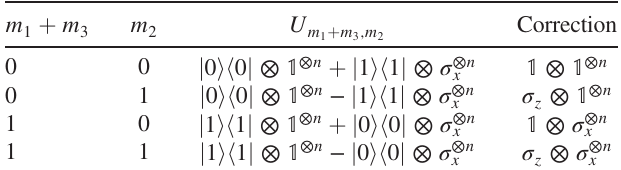
and necessary correc- m 1 þ m 3 ;m 2